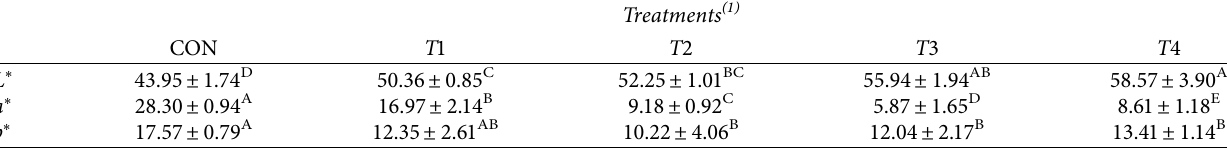
Table 4: Color of the hybrid beef patty with shiitake mushroom ( Lentinus edodes ).